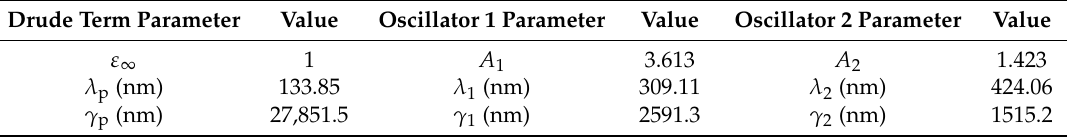
Table 2. Parameters of dielectric function of Au